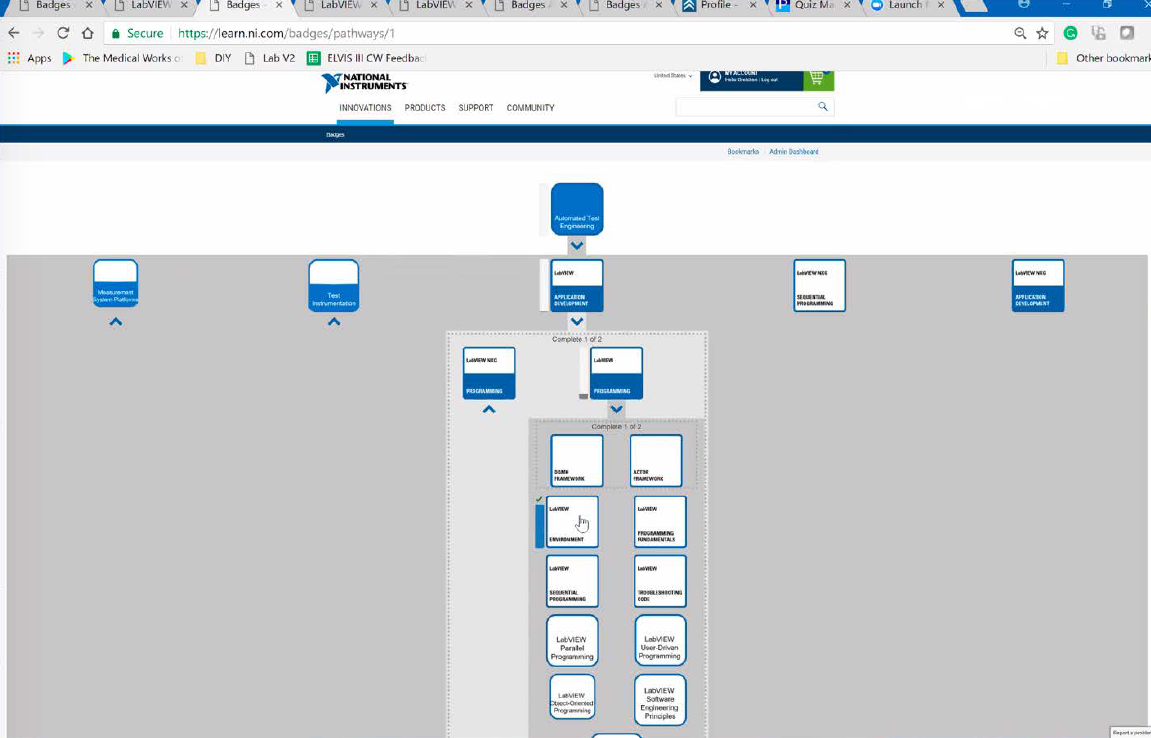
Figure 2. Learning pathways progress in National Instruments badges. From “National Instruments Badge Program,” by National Instruments, 2019b (https://learn.ni.com/badges). In the public domain. Options are provided to search or browse badges (see Figure 3), and assessments are accessed by clicking on a badge. An earner who completes an assessment without training is awarded the credential; for those who are not initially successful, training opportunities can be provided by National Instruments or its partners (see https://learn.ni.com/badges/resources/857). Allowing partners to also provide the training enables easy scalability of the National Instruments program into other